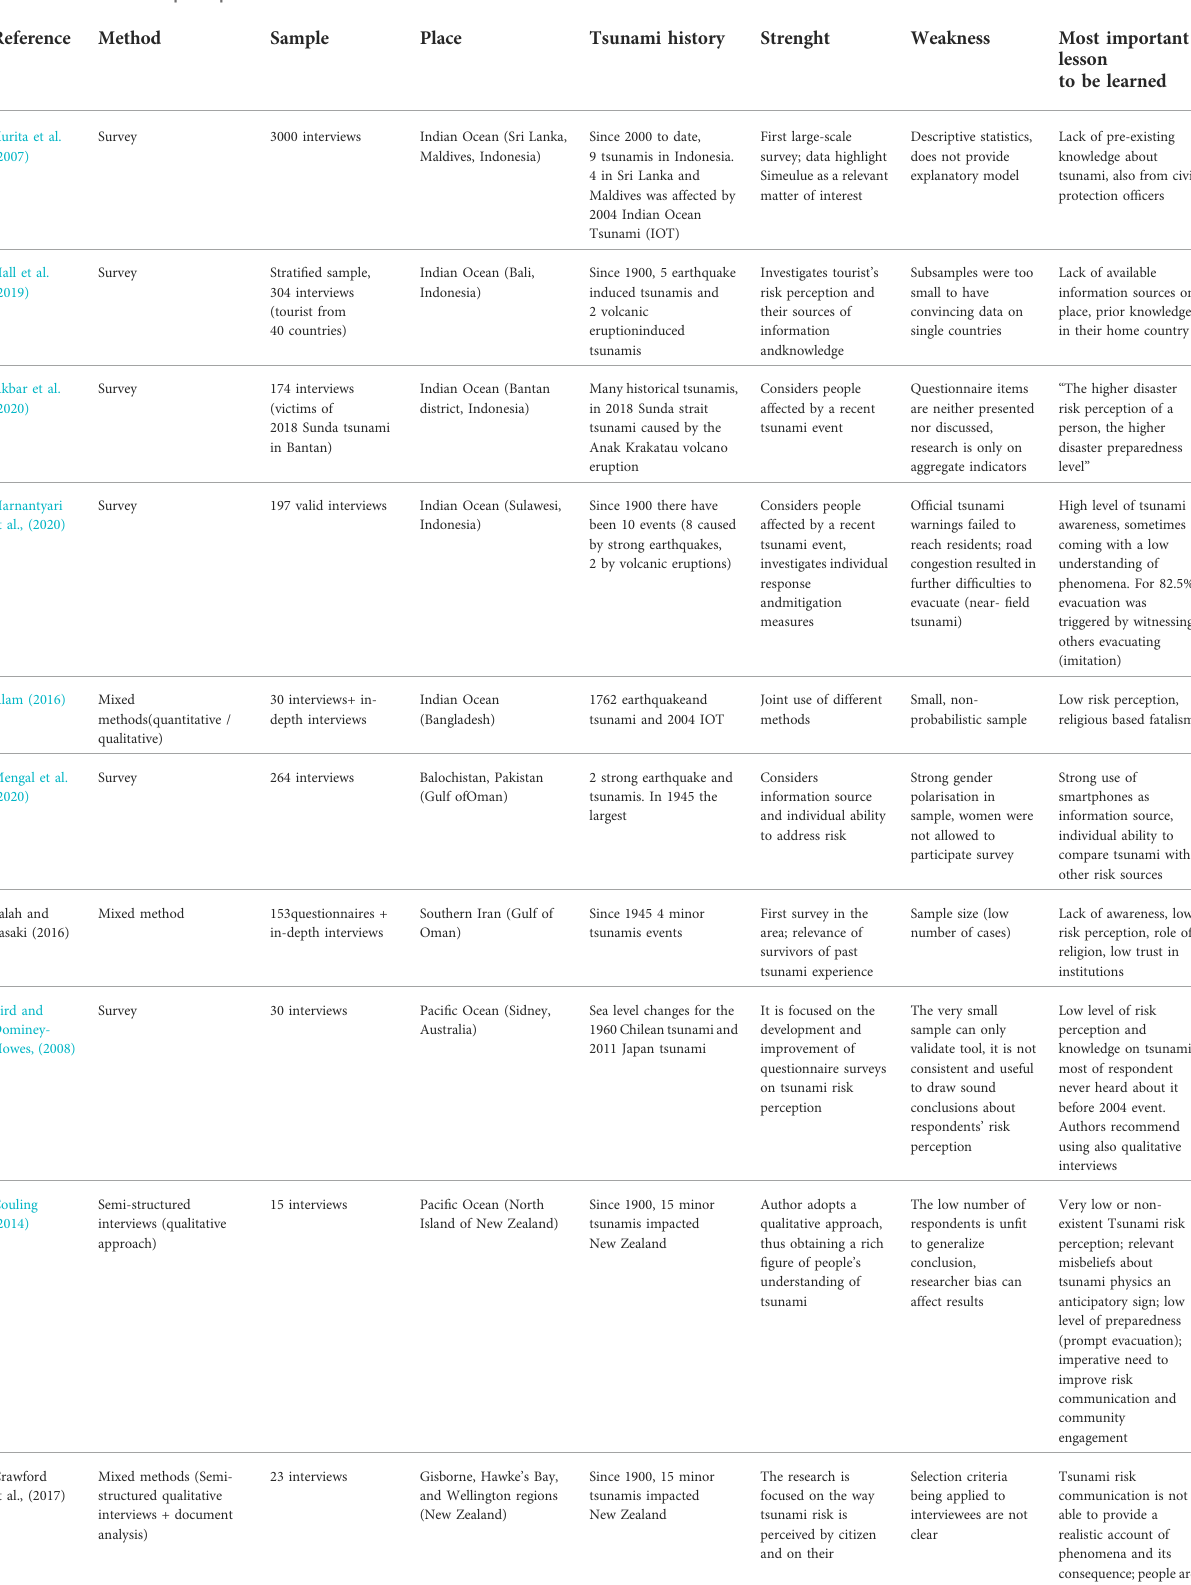
TABLE 1 Tsunami risk perception research: Review